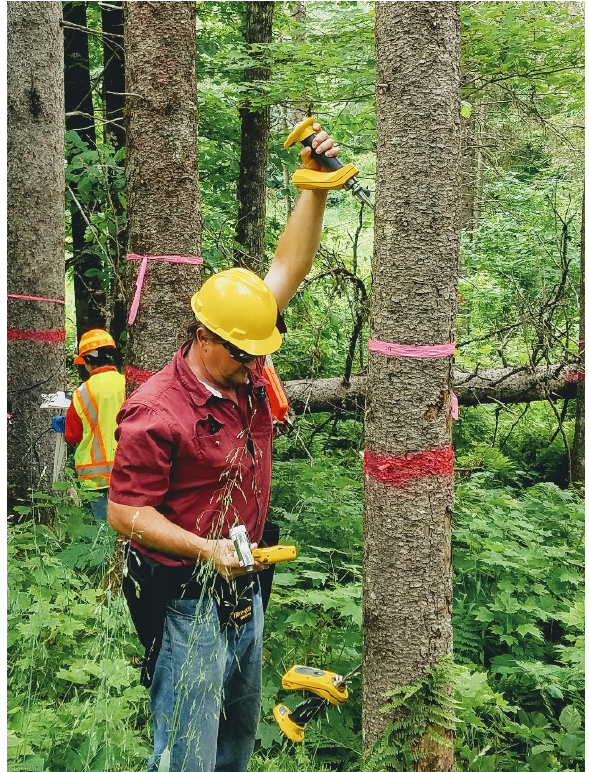
Figure 2. Longitudinal acoustic velocity measurements on white spruce trees using the Hitman ST300.